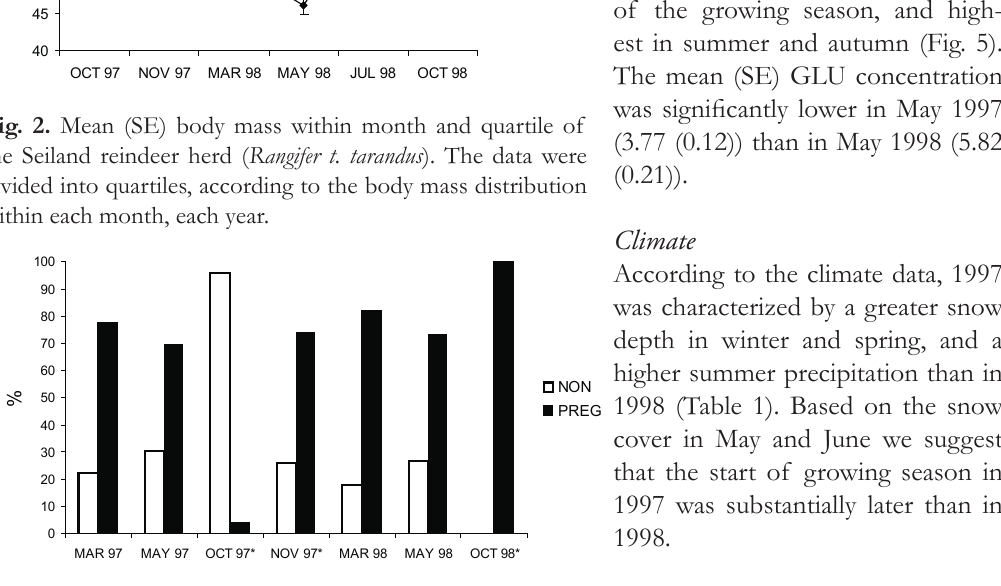
Fig. 3. Pregnancy rates in the Seiland reindeer herd as deter- mined by plasma progesterone concentrations (barren: < 7 nmo/l; pregnant: ≥ 7 nmo/l, Ropstad et al ., 1999) in 1997 and 1998. Months marked with * could also contain individuals in the luteal phase of the oestrous